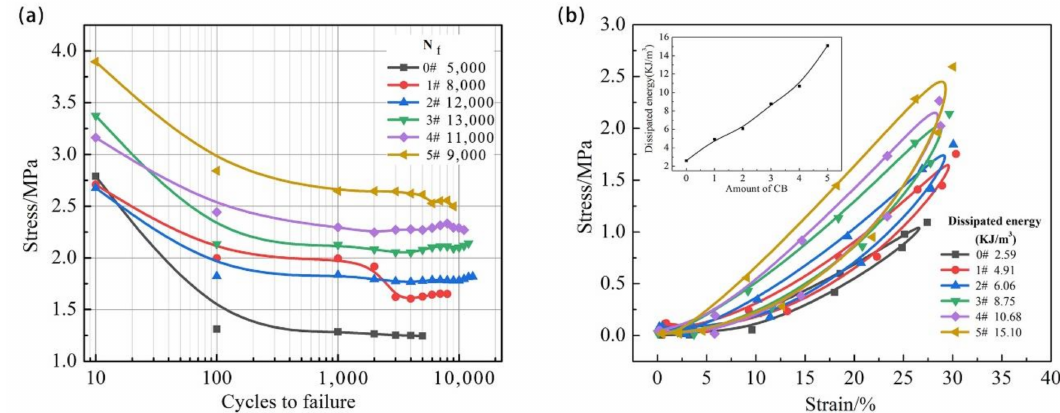
Figure 2. S–N curves ( a ) and stress–strain curves ( b ) of the unfilled and the filled SBR with different carbon black